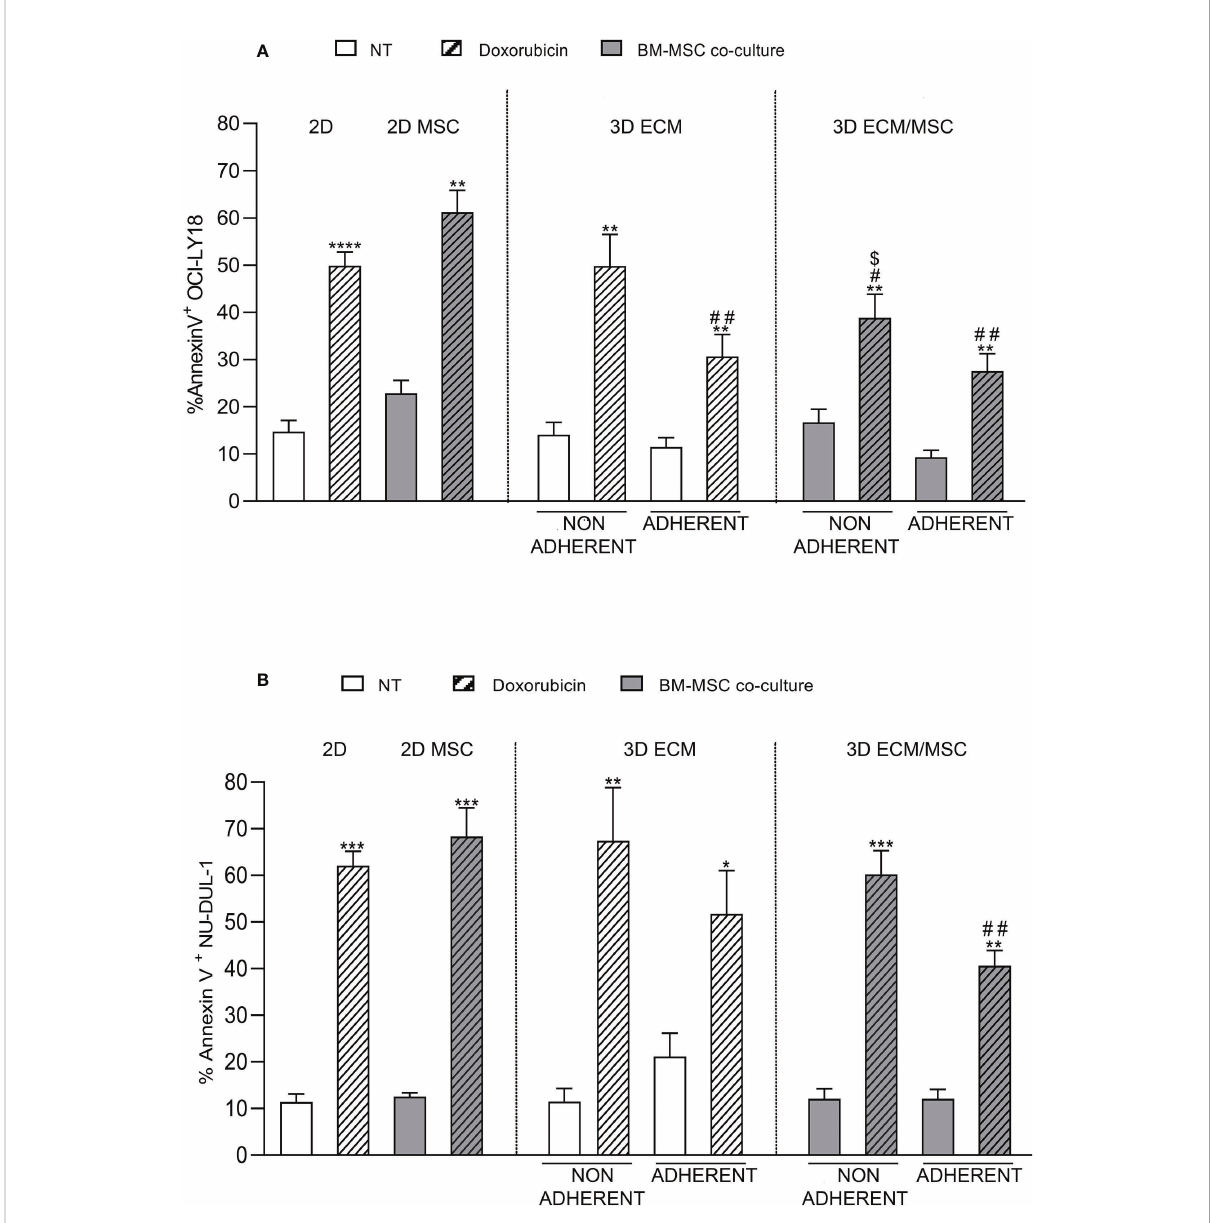
FIGURE 9 (A) Annexin V cyto fl uorometric assay of OCI-LY18 after doxorubicin treatment. The experimental conditions are summarized in Figure 1C, right panel. The apoptotic effect of doxorubicin was reduced in the ECM/MSC model adherent lymphocytes in both cell lines. With the OCI-LY18 cell line, an apoptosis reduction was also found in the ECM model adherent lymphocytes and in non-adherent cells of the ECM/MSC system. Statistical analysis: non-parametric t -test. * in relation to the non-treated conditions: * p = 0.05; ** p < 0.005; *** p < 0.0001. # in relation to the 2D-treated